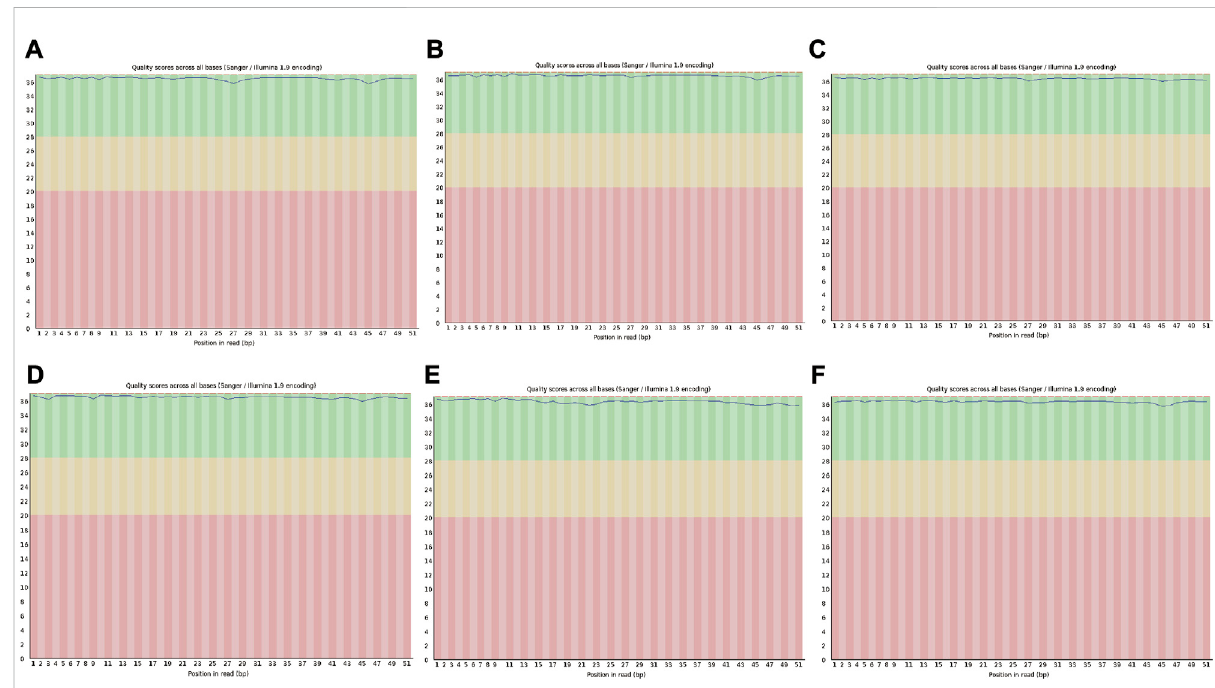
FIGURE 1 Qualityevaluationofreadlengthsinsequencing fi les. (A,BandC) representtheCONgroup. (D,EandF) representtheUACgroup.Proportionof bases with a quality value ≥ 30 (sequencing error rate of less than